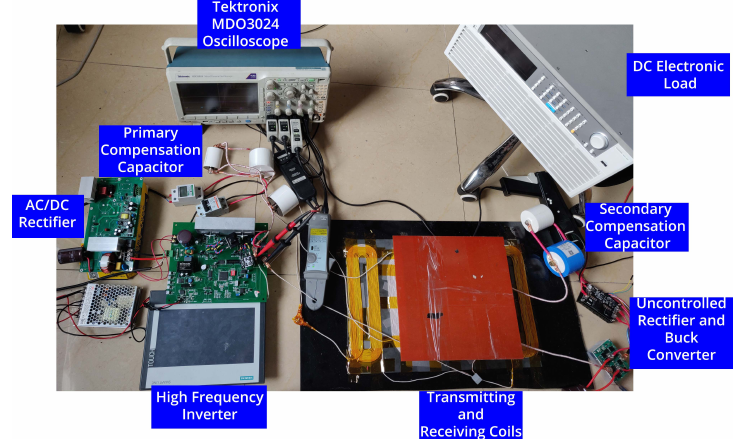
Figure 17. Experimental setup.